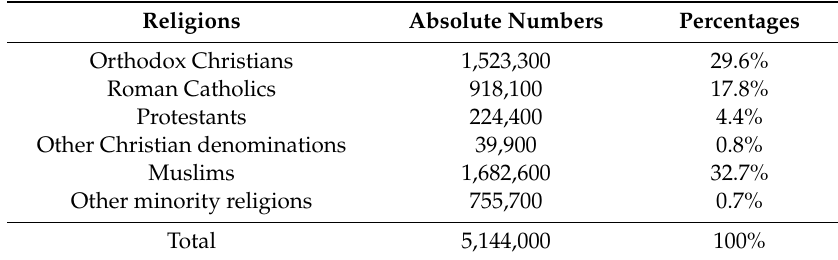
Table 2. The religious membership of